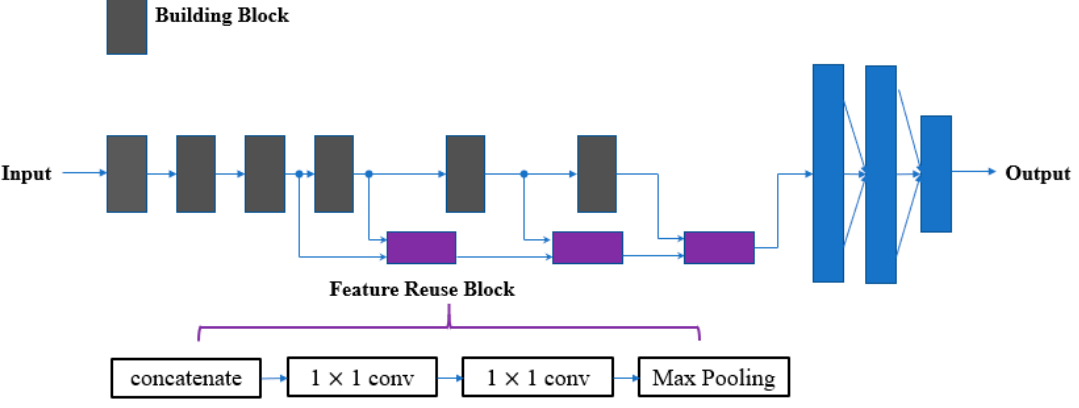
Figure 9. Proposed feature reuse method.